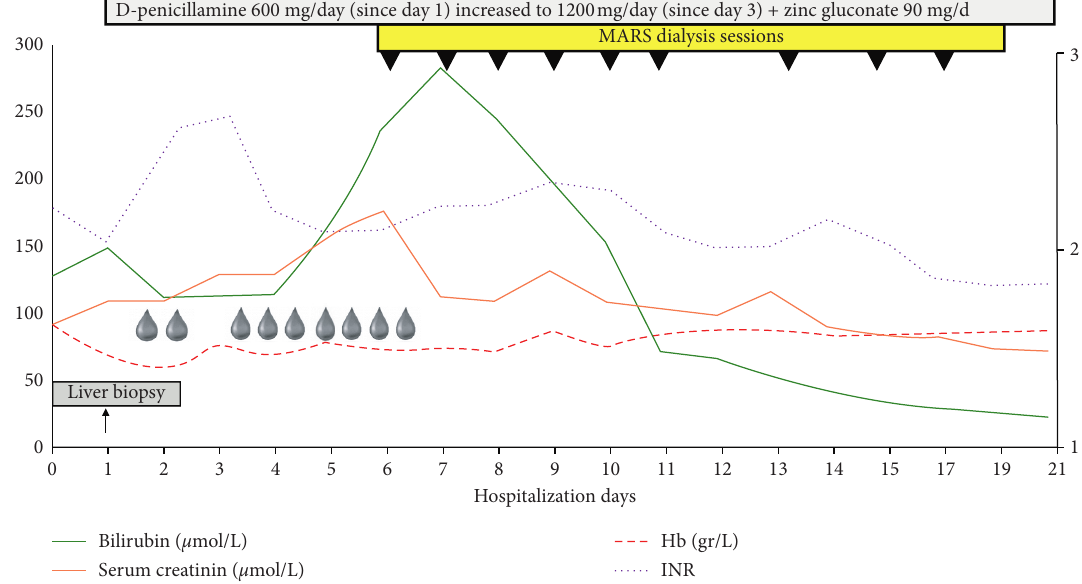
Figure 2: Graphical illustration of the patient’s course during hospitalization. Each cartoon drop indicates a blood transfusion. The violet line indicates INR, and the red dotted line corresponds to hemoglobin level. The orange line and the green solid line illustrate serum creatinine and total bilirubin values, respectively. Black triangles correspond to the individual MARS dialysis